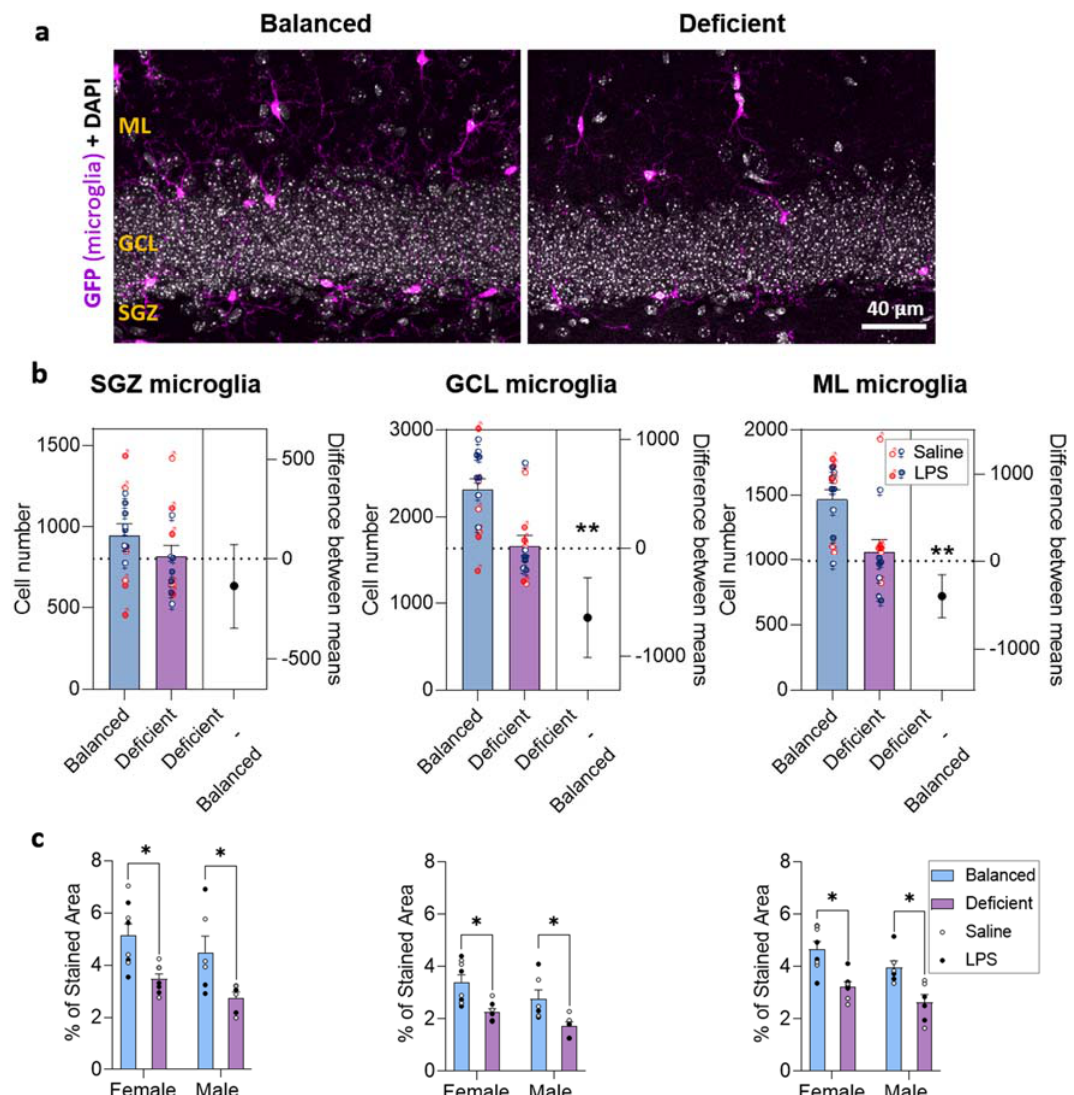
Figure 6. The n-3 PUFA deficient diet reduced microglia in the dentate gyrus (DG). ( a ) Confocal images (maximum intensity projections, z = 13.8 µ m) of the DG of the hippocampus showing microglia expressing the green fluorescence protein (GFP, magenta) in the subgranular zone (SGZ), granular cell layer (GCL), and molecular layer (ML). Images from each animal group are available in Supplementary Figure S4. ( b ) Estimation plots showing the diet effect size (difference between group means) and its associated 95% confidence interval (right axis). Mice fed with the n-3 PUFA-deficient diet showed fewer microglia in the GCL and ML than those fed with the balanced diet (no effects of LPS or sex detected). ( c ) Furthermore, the area occupied by microglia was reduced in the SGZ, GCL, and ML of mice fed with the n-3 PUFA-deficient diet compared to those fed with the balanced diet (interaction between diet and sex detected in the GCL and ML, no effect of LPS de ‐ tected). * p < 0.05, ** p < 0.01 (statistics detailed in Supplementary Data).